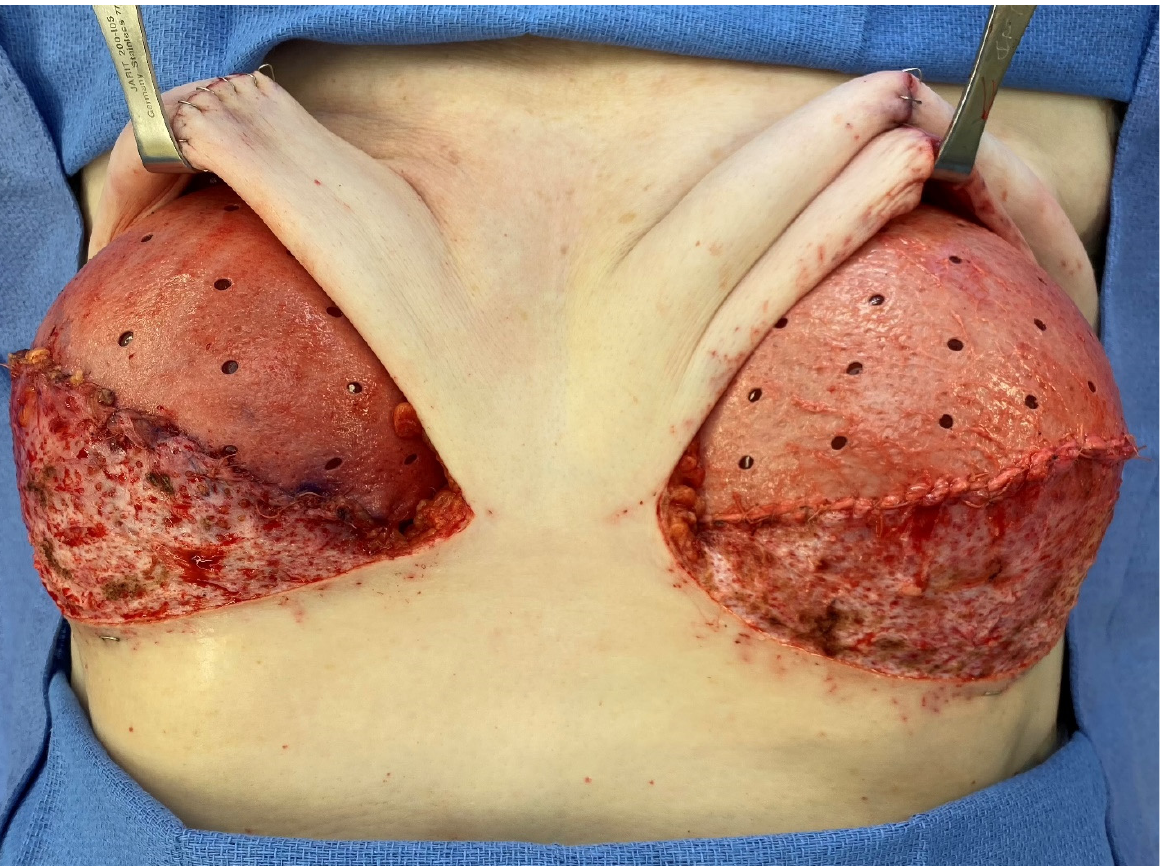
Figure 2. Intra-operative picture. For each breast, the superior-anterior part of the implant is covered by an ADM patch, sutured to a dermal sling that covers the inferior-anterior part of the implant.